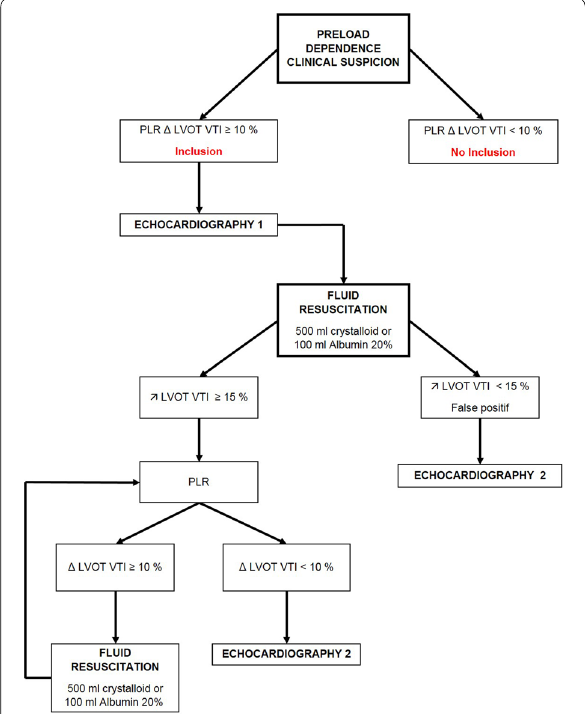
Fig. 1 Flow chart protocol. PLR, passive leg raising; PLR Δ LVOT VTI, passive leg raising variation of left ventricular outflow track velocity– time integral; ↗ LVOT VTI, increase of left ventricular outflow track velocity–time integral after fluid